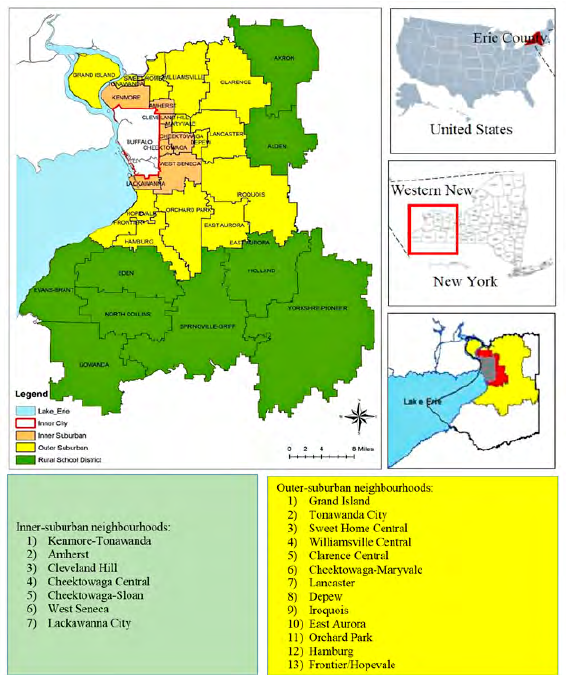
Figure 1. Study area: Buffalo Metropolitan Area, New